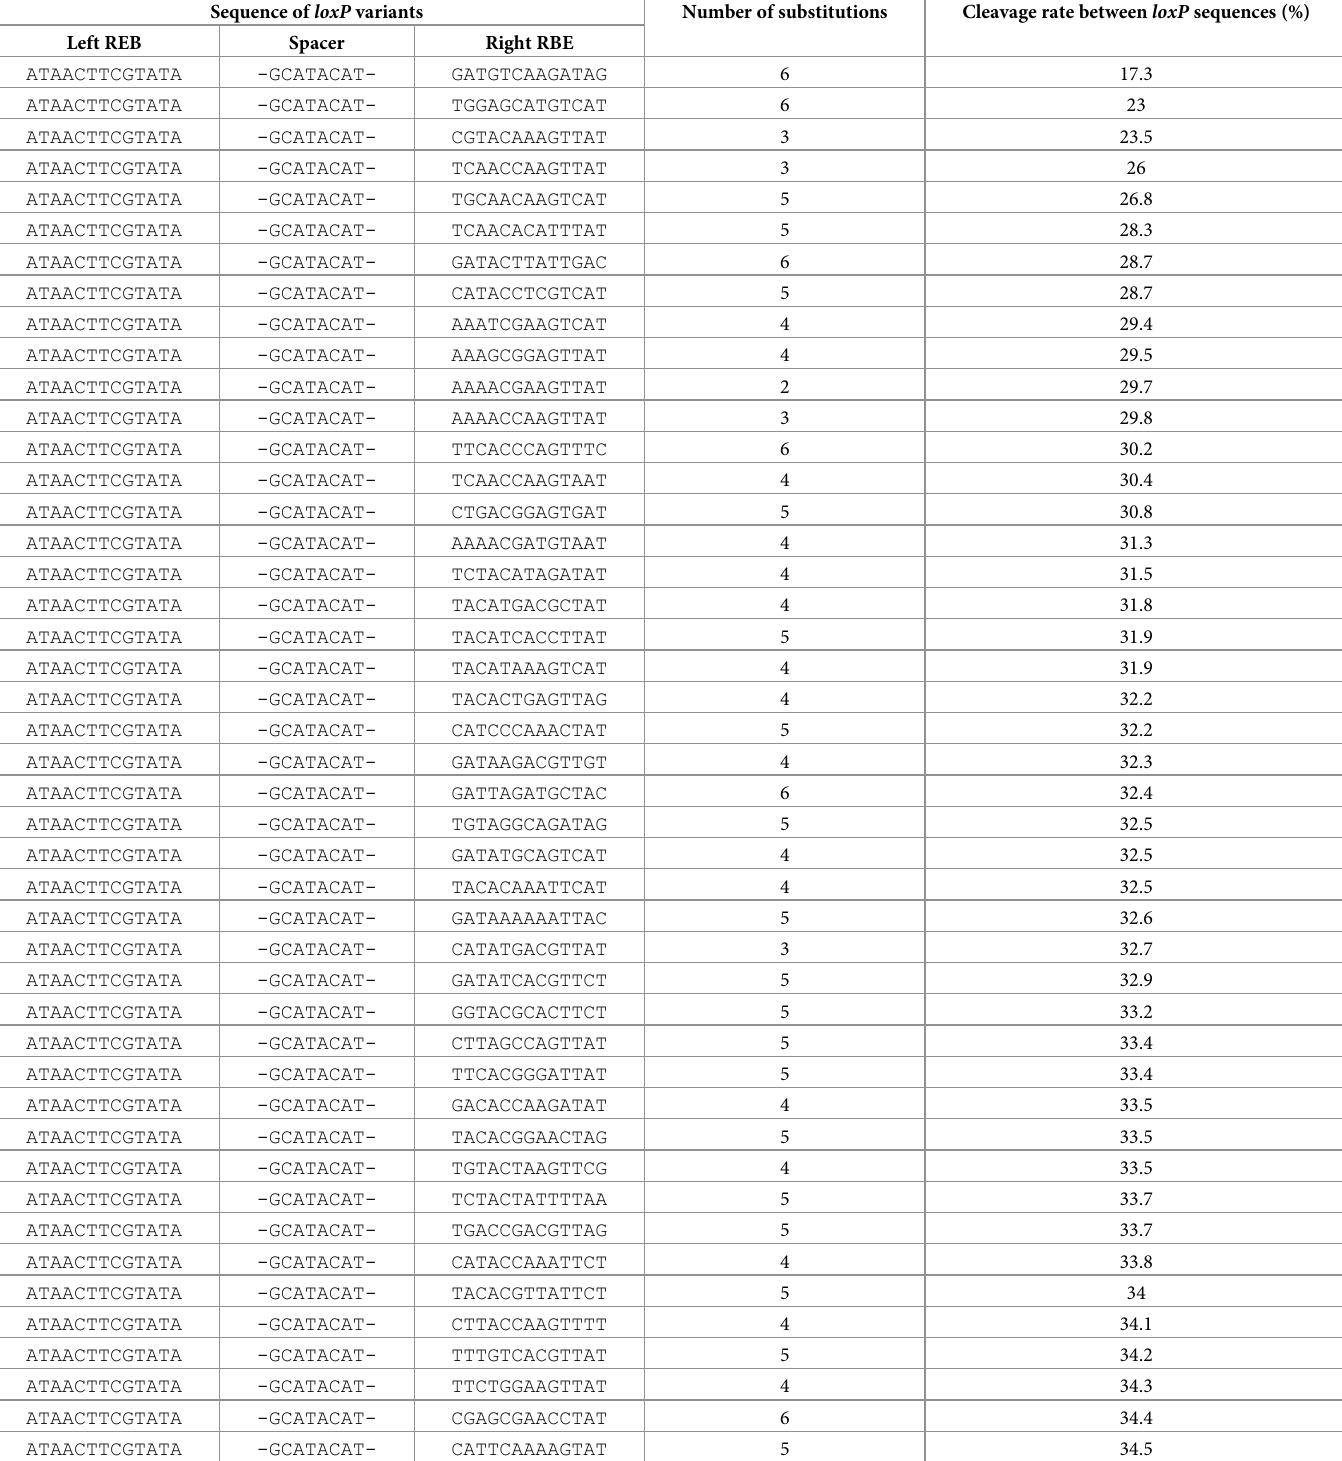
Table 1. List of top 50 mutant loxP sequences with the lowest recognition rate by Cre among evaluated loxP variants. The underlined bases indicate mutated positions. Sequence of loxP variants Number of substitutions Cleavage rate between loxP sequences